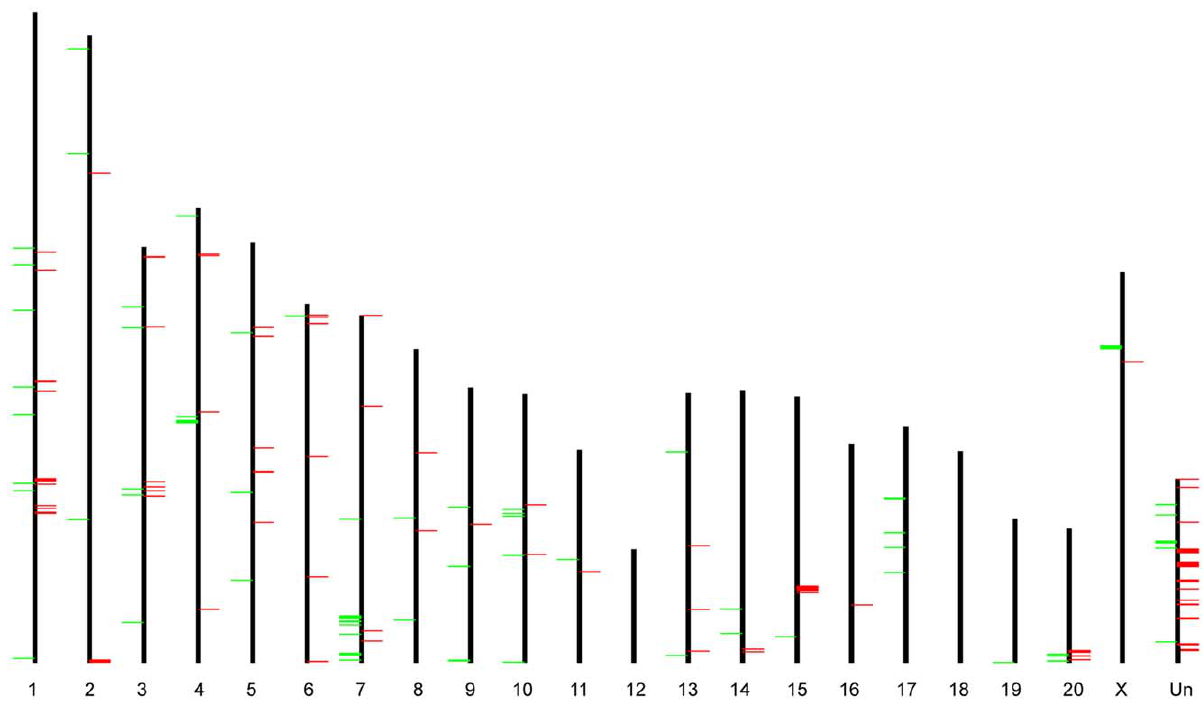
Figure 1. Chromosomal distribution of GK/Wistar CNVRs. Green bars on the left and red bars on the right of chromosomal axes represent CNV ‘‘loss’’ and ‘‘gain’’, respectively. Chromosome ‘‘Un’’ represents the pseudo-chromosome consisting of contigs that can not be confidently mapped to a specific chromosome.